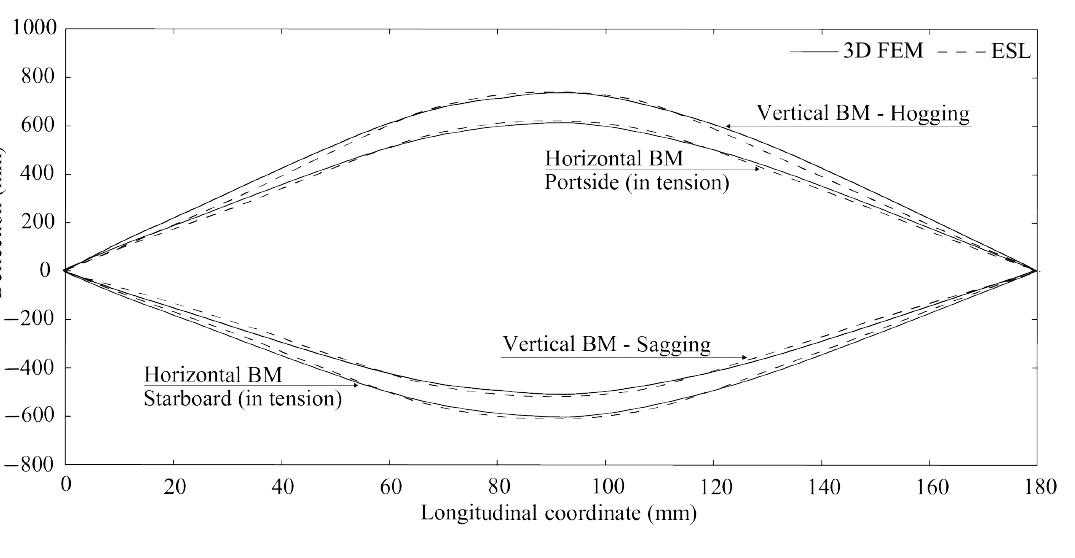
Figure 11. Deflection of ship’s hull along its length at the ultimate stage under vertical and horizontal bending moments.